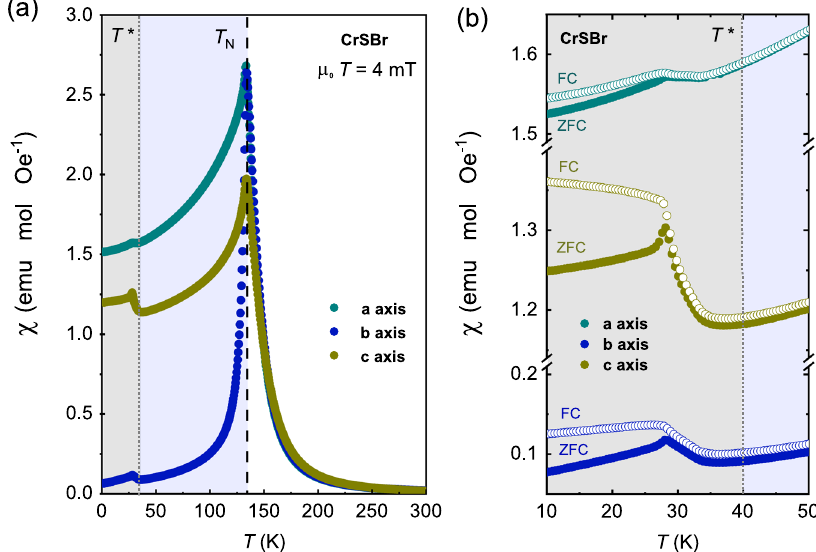
Fig. 4 | Temperature-dependant magnetization of CrSBr. a Magnetic suscept- ibility for a CrSBr single crystal at different relative orientations. b Enlarged low- temperature region showing the susceptibility in zero fi eld cooling (ZFC; fi lled